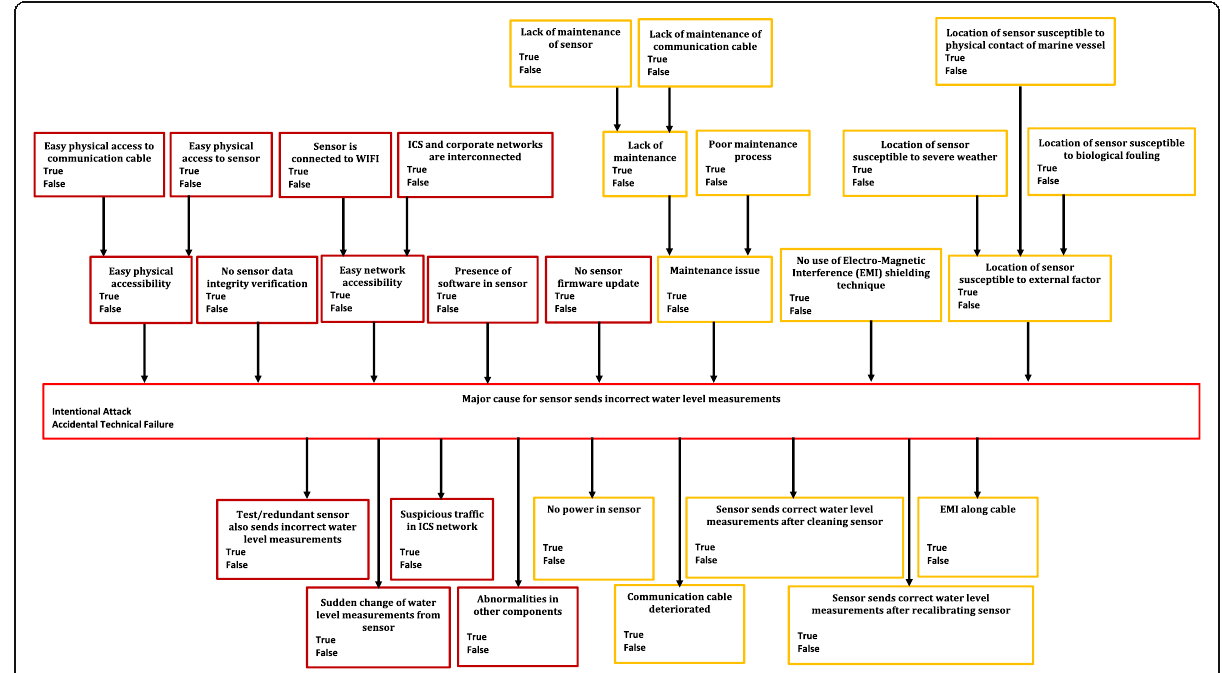
Fig. 4 Constructed Qualitative BN Model. (In this Figure, the presence of contributory factors and observations (or test results) colored in dark red would increase the likelihood of the problem (colored in red) due to an attack on the sensor. Furthermore, the presence of contributory factors and observations (or test results) colored in orange would increase the likelihood of the problem due to sensor